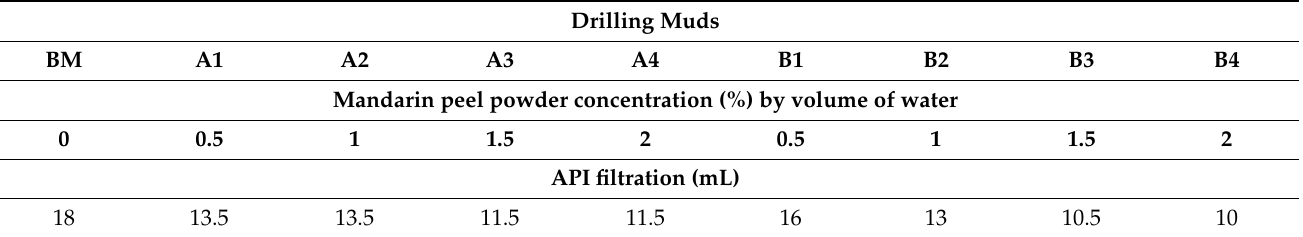
Table 3. Influence of adding MPP on API filtration [46]. Drilling